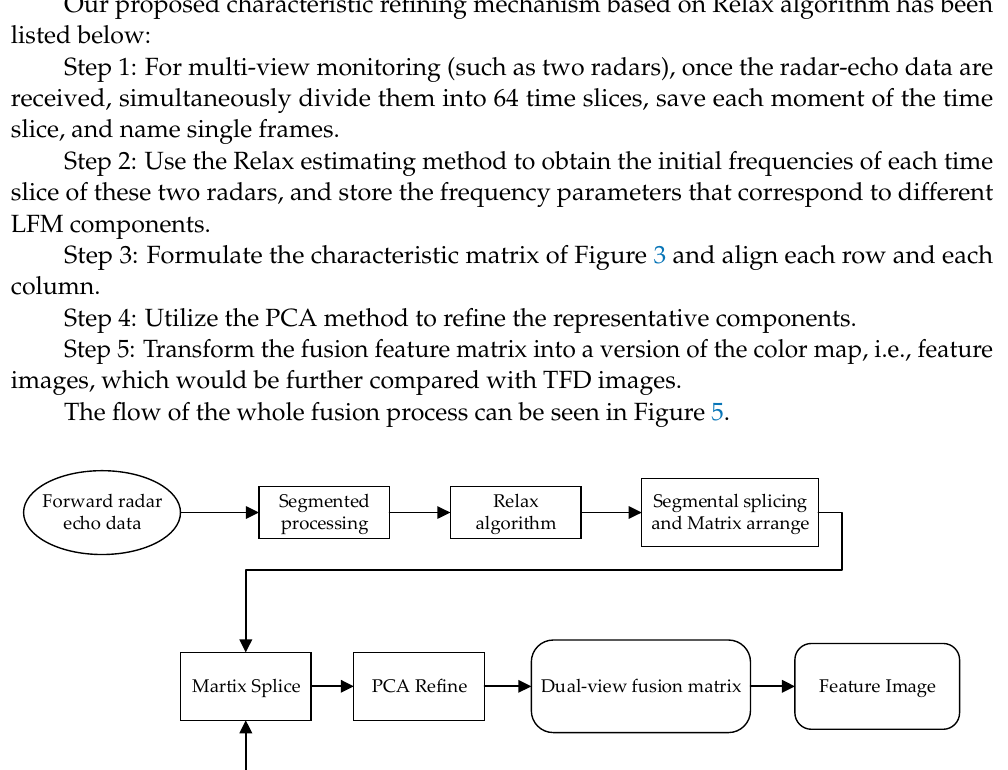
Figure 4. Refine the characteristic matrices using PCA. (PC m represents the m -th principal component).